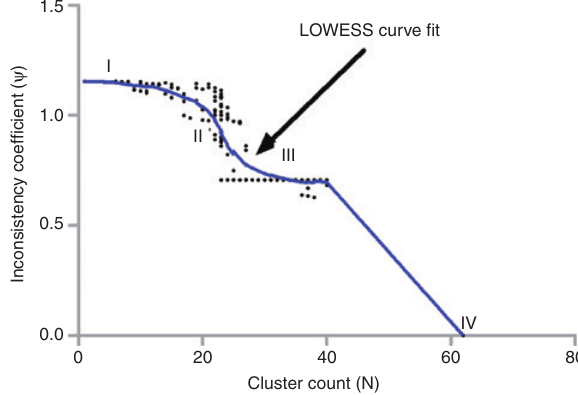
Figure 9: LOWESS curve fit and different segments ( Vf =